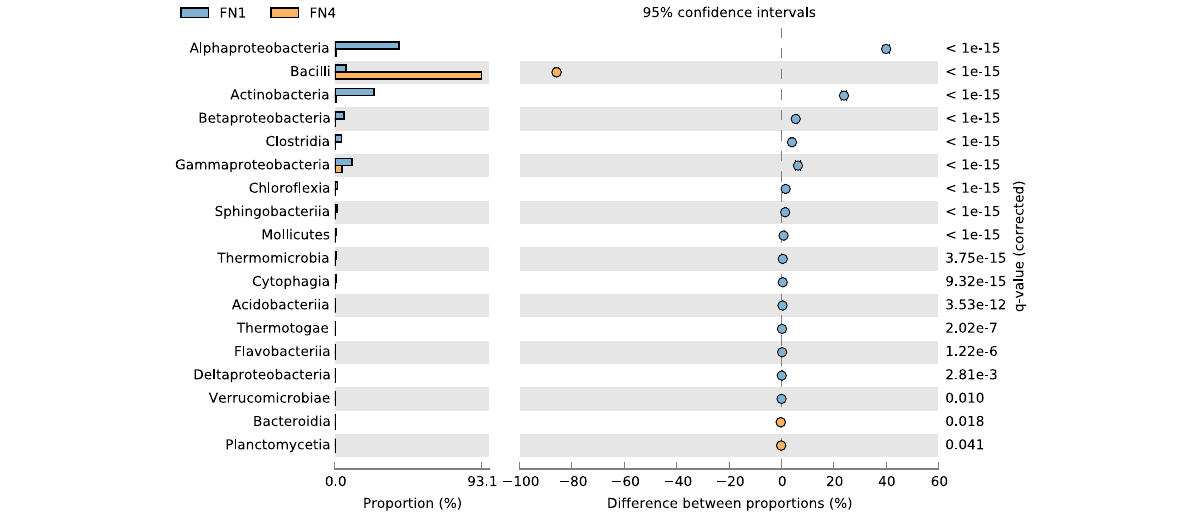
Fig. 2 Comparative taxonomic profile of the FN1 and FN4 metagenomes at class delineation, computed by Kraken. Only classes with significant biological differences as determined by STAMP ( P < 0.05, difference between the proportions > 1% and twofold of ratio between the proportions) are